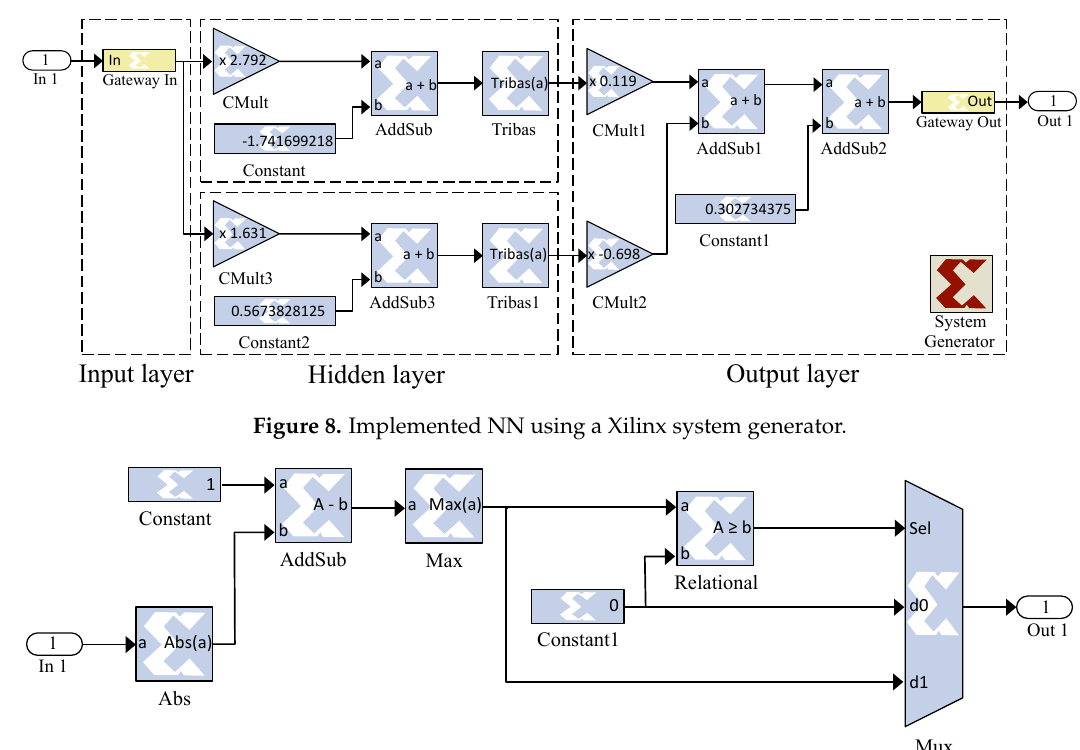
Figure 9. Implemented triangular function using a Xilinx system